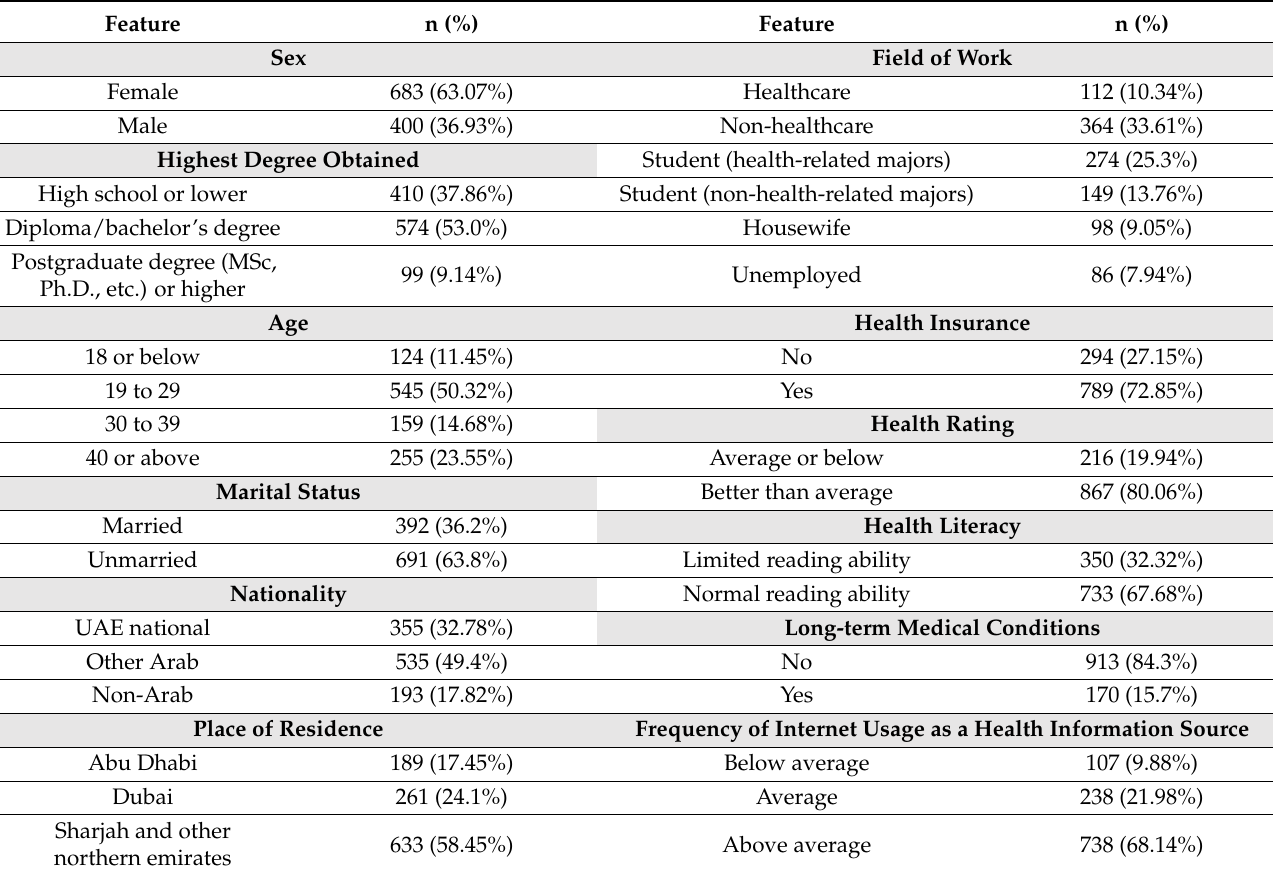
Table 1. The various demographic variables of a total of 1083 responses with no missing